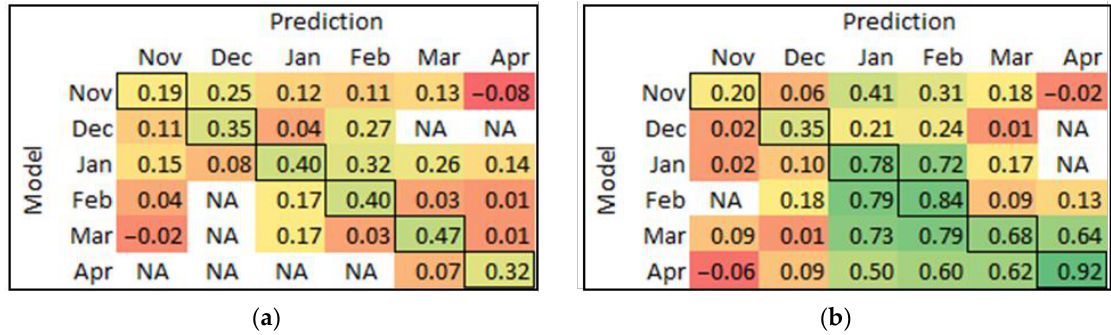
Figure 7. The matrix of MCC from each model prediction of other timepoints for ( a ) Chardonnay, and ( b ) Pinot Noir. The bold cells are the self-predicted results, which are equal to the calibration results. The colour score ranges from red (low value) to yellow (medium) to green (high value). NA means √((TP + FP)∙(TP + FN)∙(TN + FP)∙(TN + FN)) equal to zero that cannot be divided.